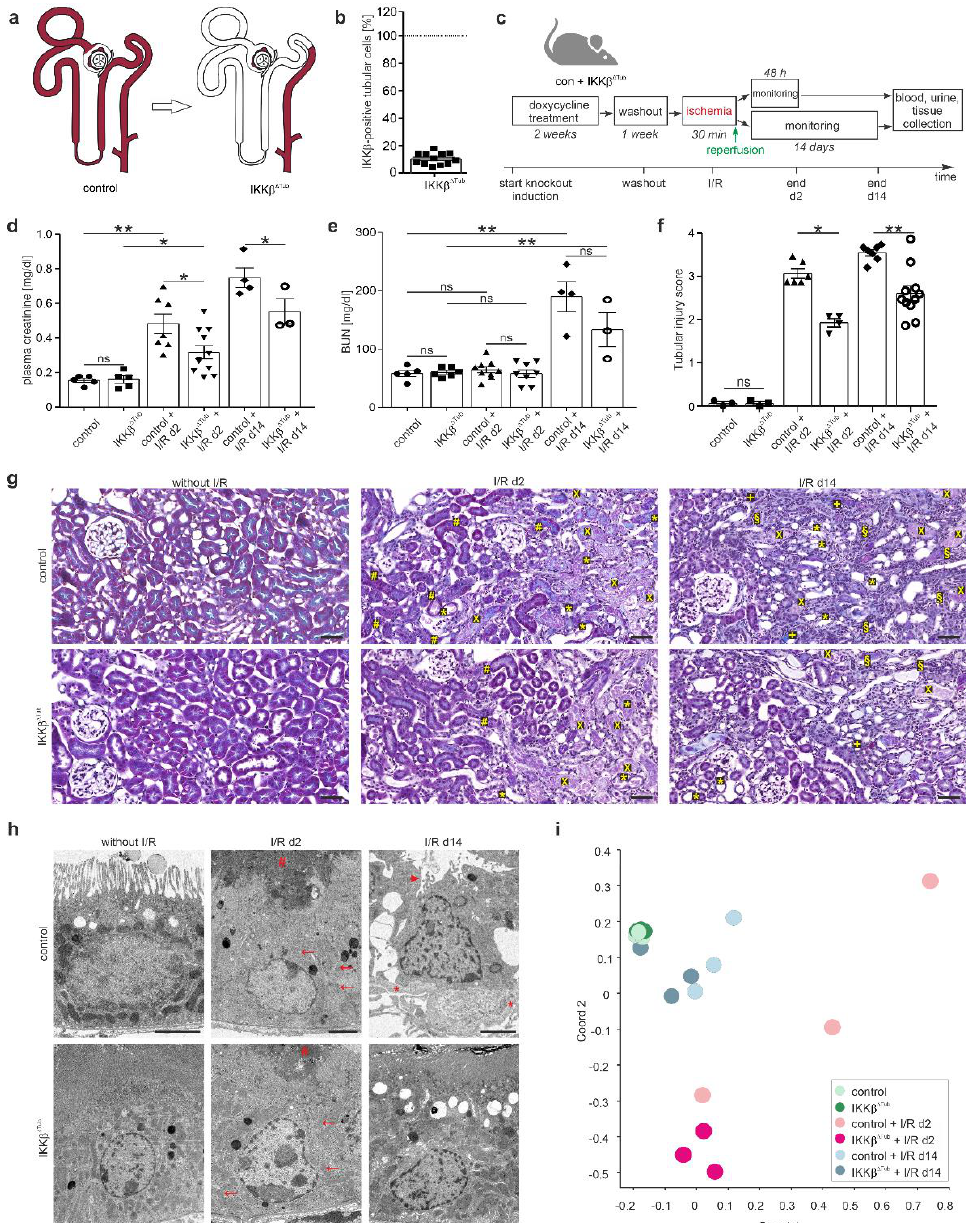
Figure 1. Genetic tubular IKK β -deletion ameliorates I/R injury. ( a ) Scheme illustrating deletion of IKK β gene under Pax8 promoter along the tubule; ( b ) semi-quantitative analysis of IKK β mRNA expression derived from Exon 3 in tubular cells of control and IKK β ∆Tub . Arithmetic means ± SEM of n = 12 per group; * p < 0.05, t -test; ( c ) timeline of experimental procedure; ( d , e ) plasma creatinine ( d ) and blood urea nitrogen (BUN; ( e )) values of control and IKK β ∆Tub at baseline, 2 days and 14 days after I/R injury. Arithmetic means ± SEM of n = 3–11 per group; ( f ) semi-quantitative evaluation of tubulointerstitial injury. Arithmetic means ± SEM of n = 3–11 per group; ( g ) representative images of Masson trichrome stained kidney section of control and IKK β ∆ Tub at baseline, 2 days and 14 days after I/R injury. Scale bar = 50 µ m. Tubular necrosis (x), loss of brush border (*), eosinophilic debris (#) and cellular infiltration (§) and fibrotic areas (+) are shown; ( h ) representative electron